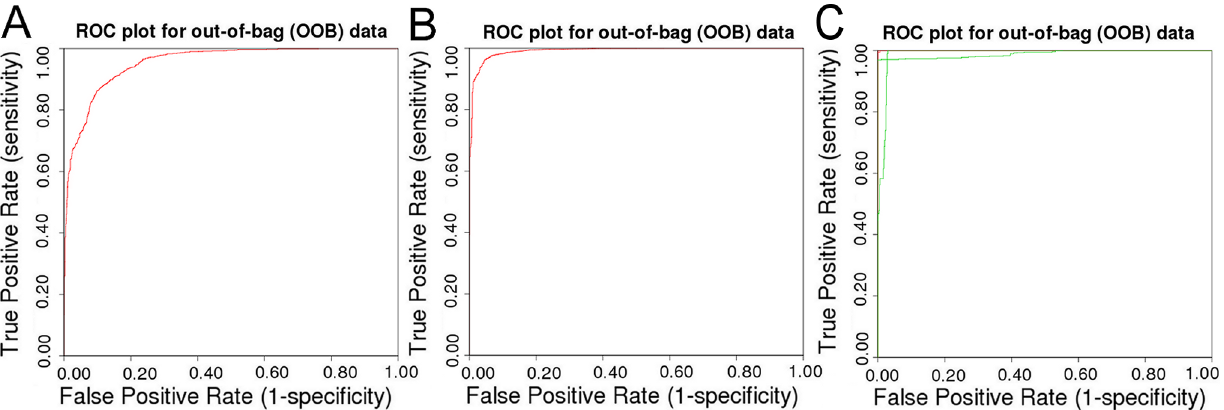
Figure 7. ROC curves for out-of-bag validation of the allosteric classifier models trained in case studies 2–4. (A) ROC curve for the HIV- RT classifier. (B) ROC curve for the adenosine receptors classifier. (C) ROC curve for the Protein Kinase B classifier (note that here a ternary model was used as opposed to a binary model).